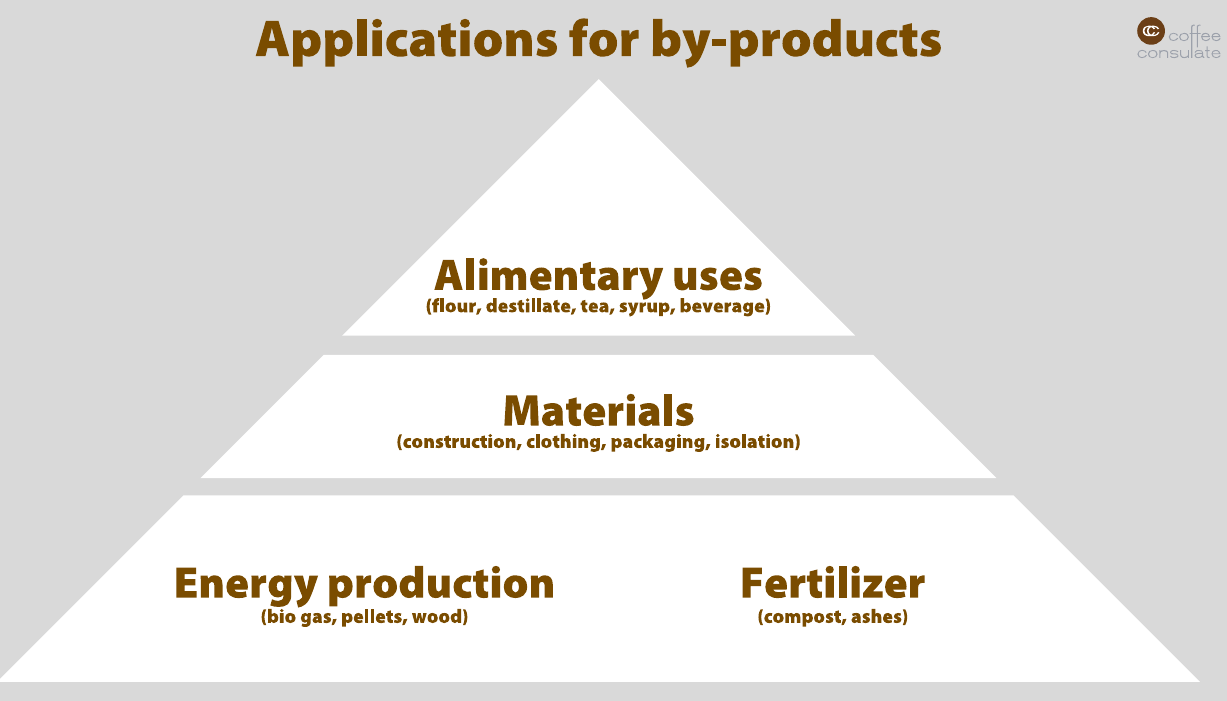
Figure 3. Pyramid model for applications of coffee by-products.